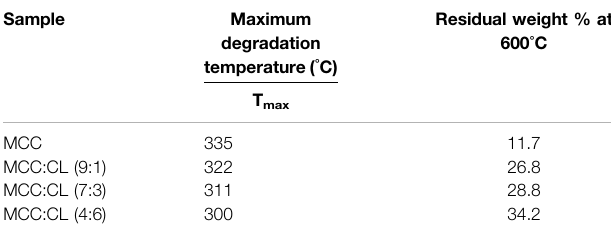
TABLE 3 | Thermal properties of the MCC fi lm and MCC:CL biocomposite fi lms. Sample